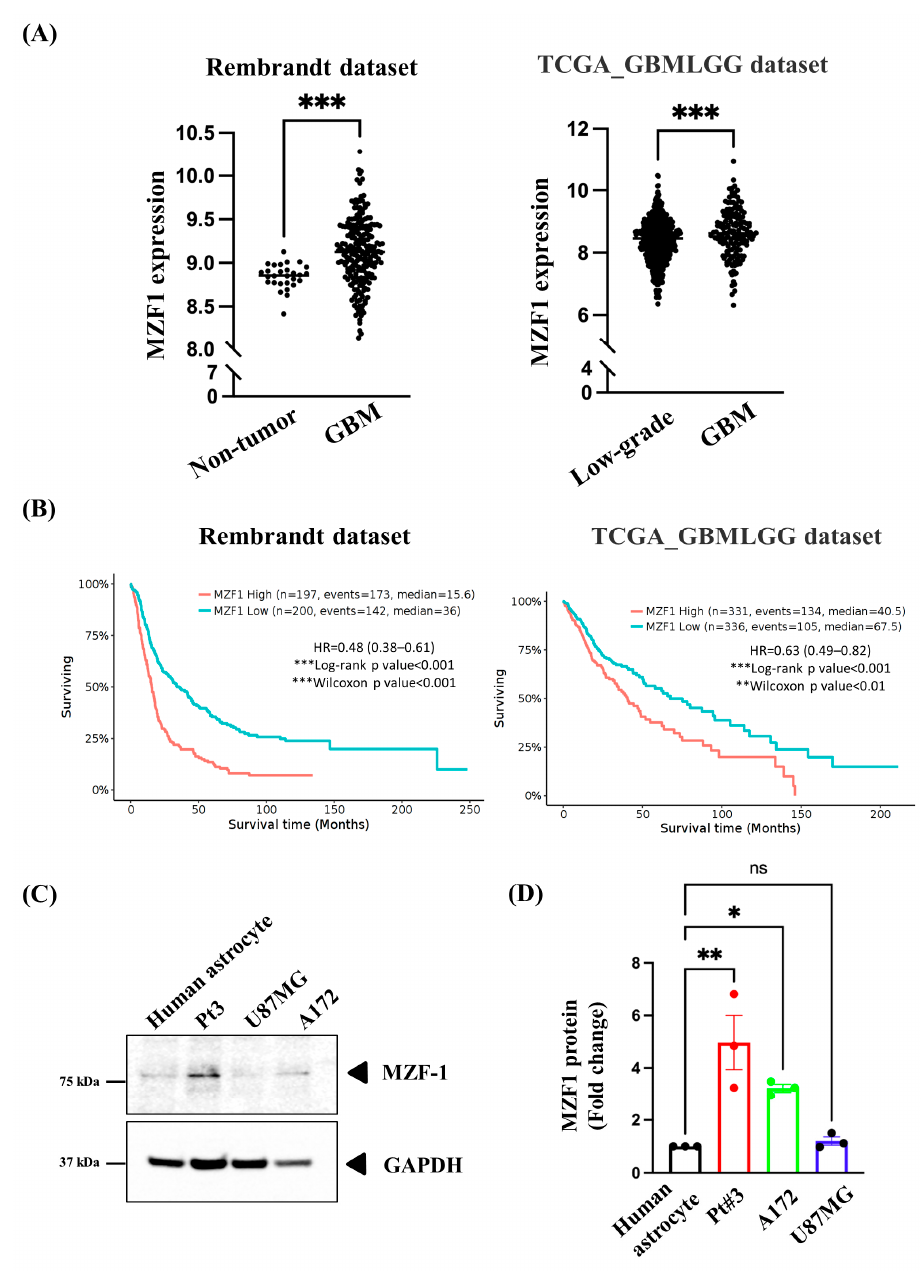
Figure 1. MZF1 was highly expressed in glioblastoma and associated with poor survival. Using the GlioVis data visualization tool (Rembrandt dataset and TCGA_GBMLGG dataset), we analyzed ( A ) MZF1 expression and ( B ) overall survival rates in GBM. MZF1 expression was demonstrated to be higher in GBM than in normal tissues and low-grade gliomas and correlated with a poorer prognosis. ( C ) Representative western blot image of the level of MZF1 protein in human primary astrocytes and gliomas (PT#3, A172, and U87MG). ( D ) Quantification of the data from ( C ) showed statistically significant increase in MZF1 levels in PT#3 and A172 cells compared with human primary astrocytes, but not in U87MG cells. Data are collected from three independent experiments and presented as mean ± SEM; one-way ANOVA followed by Dunnett’s multiple comparisons test, p = 0.0019 (human primary astrocytes vs. PT#3 cells) and p = 0.0435 (human primary astrocytes vs. A172 cells), * p < 0.05, ** p < 0.01, and *** p < 0.001. ns: no statistical significance.